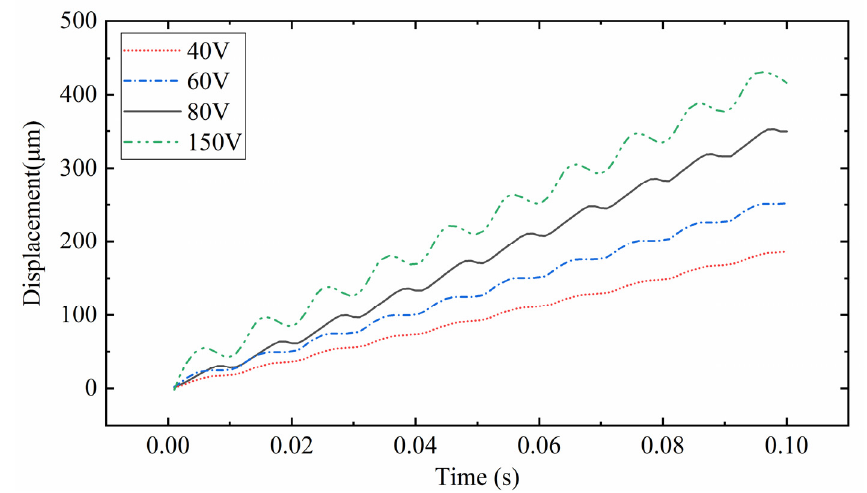
Figure 26. Relationship between displacement and time of mover under different excitation V p-p .